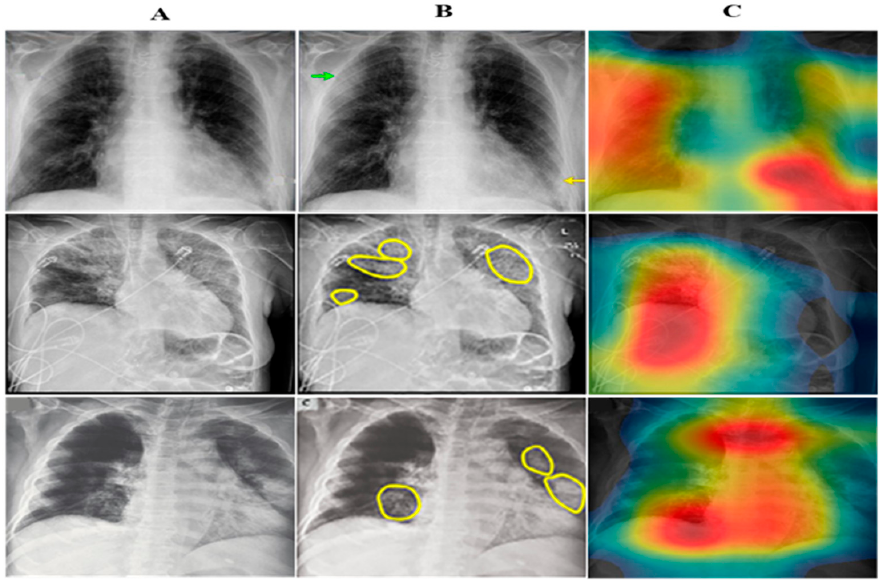
Figure 10. Panel ( A ) illustrates X-ray images. In panel ( B ), COVID-19 infected region is highlighted with an arrow or yellow circle by radiologists. Panel ( C ) shows the heat map of the proposed